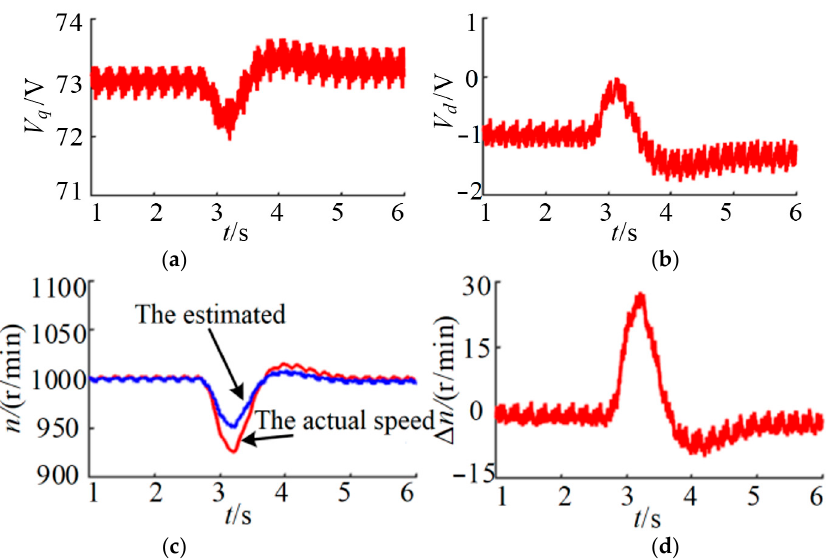
Figure 8. Estimated back EMF curve at the speed mutation. ( a ) V q curve. ( b ) V d curve.